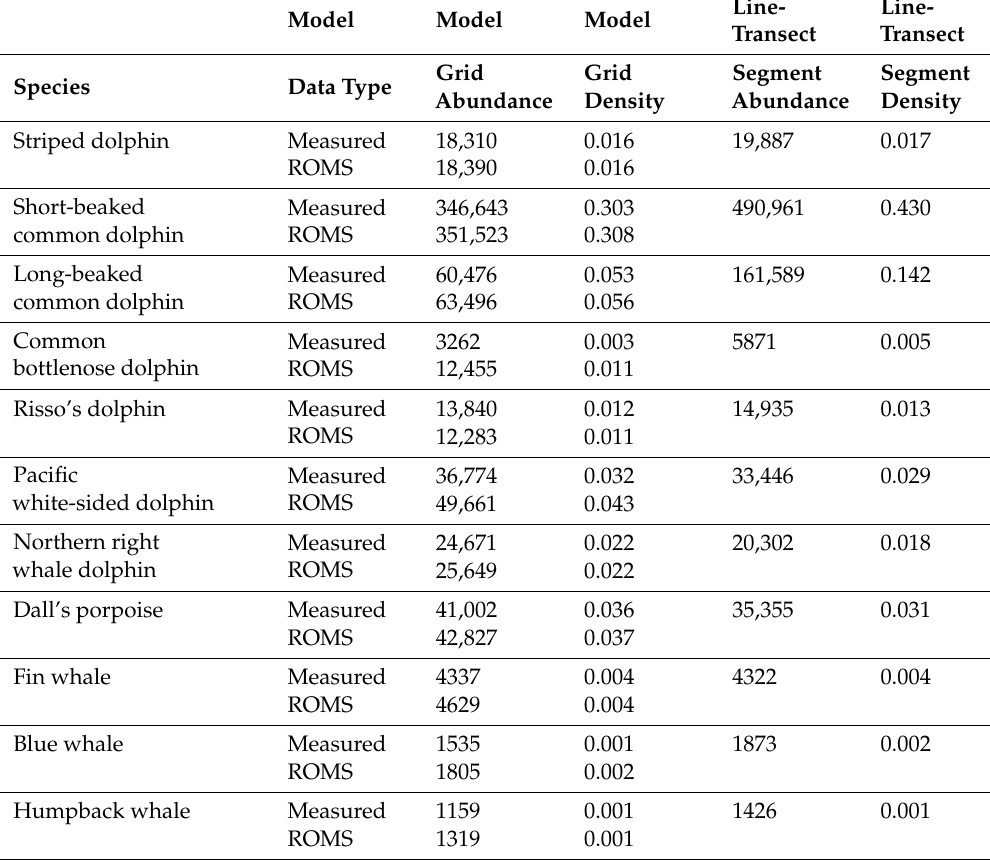
Table 3. Predicted abundance and density estimates for the California Current study area from GAMs built with either measured data or ROMS output. “Grid” abundance values were calculated as the sum of the individual model-predicted grid cell abundances throughout the study area. Segment-based line-transect abundance and density estimates were made using standard methods without the inclusion of habitat predictors. Uncertainty is not presented since all estimates were derived from the same dataset and included the same parameters, i.e. , segment-specific estimates of ESW and g(0) . Line- Model Model Model Transect